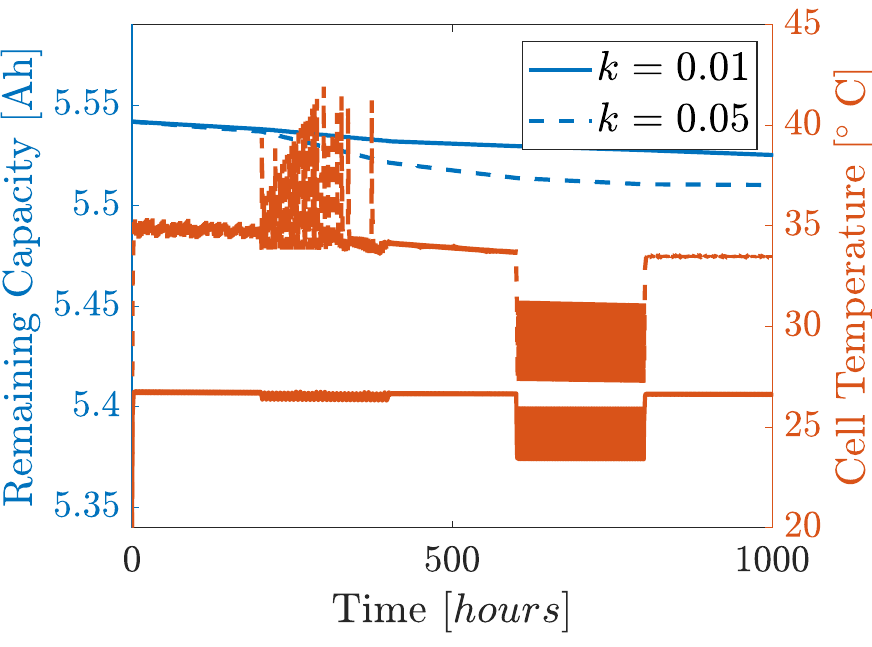
Figure 18. SoH: Effect of the gain k on Battery